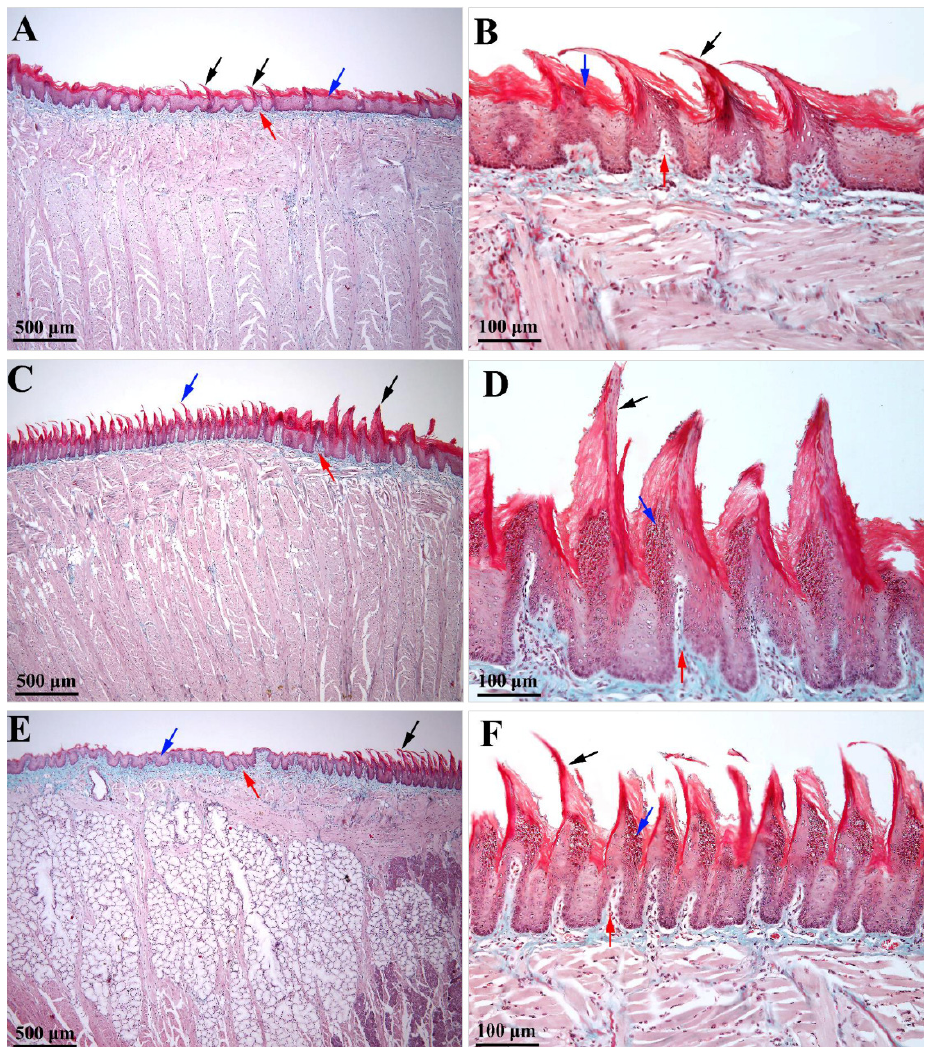
Figure 2. Microscopical features of the tongue of a white Wistar rat (Goldner’s trichrome stain): ( A ) anterior portion of the lingual body that presents short filliform papillae (black arrow); squamous stratified keratinized epithelium (blue arrow) disposed on lamina propria (red arrow); ( B ) the anteroposterior inclination of the filliform papillae (black arrow) from the anterior portion of the lingual body, with a thicker covering of keratinized squamous stratified epithelium on the anterior part of each filiform papilla (blue arrow) and subjacent lamina propria (red arrow); ( C ) the orientation of the filliform papillae from the posterior portion of the lingual body (blue arrow) compared to the ones from the lingual protuberance (black arrow), which are sustained by a thicker lamina propria (red arrow); ( D ) lingual protuberance with a distinct posteroanterior-inclined conical filliform papillae (black arrow) which have a prominent granular layer highly charged with keratohyalin granules on the posterior face of the papillae (blue arrow) vs. the anterior face; red arrow suggests the sustaining connective tissue of the filliform papillae; ( E ) crossing area from the posterior portion of the lingual body (black arrow) and the root of the tongue (blue arrow), the last one displaying only some elevation of covering the epithelium on the sustaining lamina propria (red arrow); ( F ) details of the posterior portion of the lingual body that includes anterioposteriorly oriented filliform papillae (black arrow) with a prominent granular layer (blue arrow) on the anterior face of each papilla; sustaining lamina propria protruding in the central ax of the filliform papillae (red arrow). Some differences were detected in the covering epithelium of the filiform papillae from the anterior part of the tongue, as compared to the posterior one. Thus, the